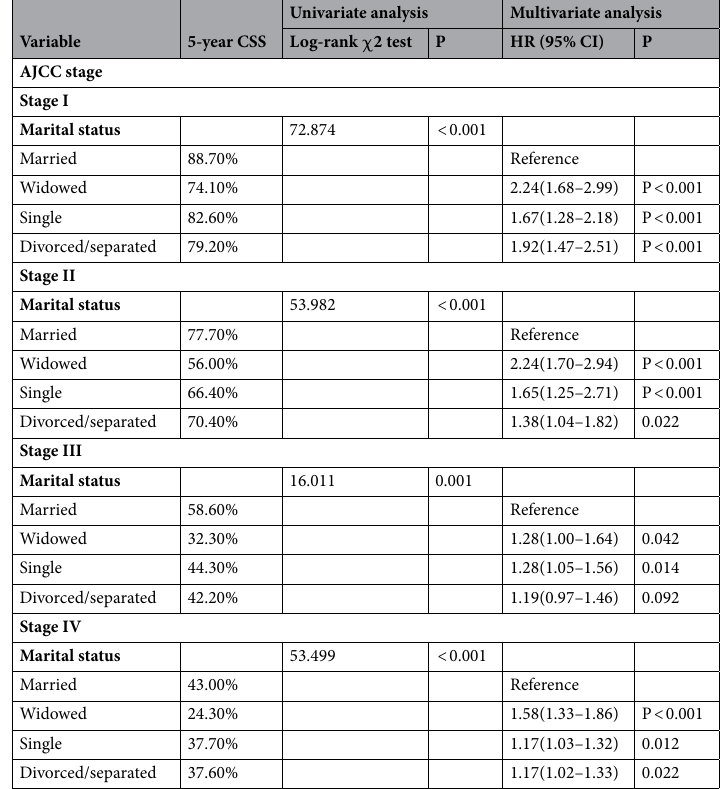
Table 5. Univariate and multivariate analysis of the effect of marital status on laryngeal cancer CSS based on different cancer stages before PSM. CSS, cancer-specific survival; PSM, propensity score matching; HR, hazard ratio; CI, confidence interval.